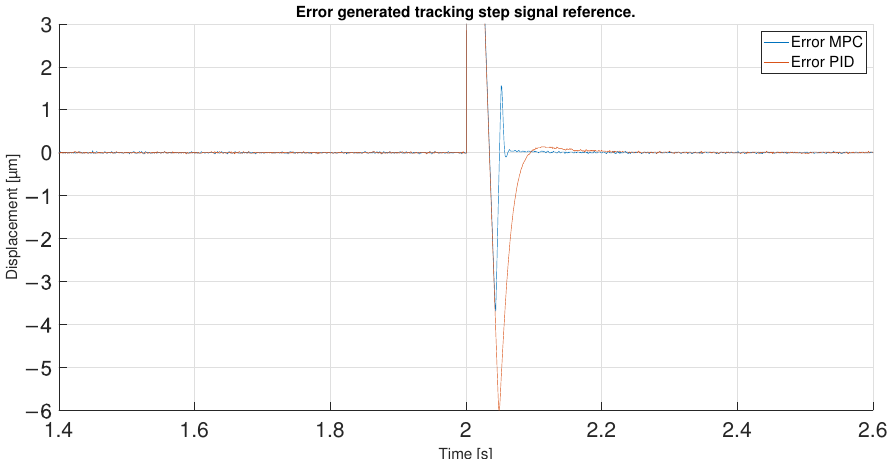
Figure 30. Error of tracking of the PID and MPC for a step reference.